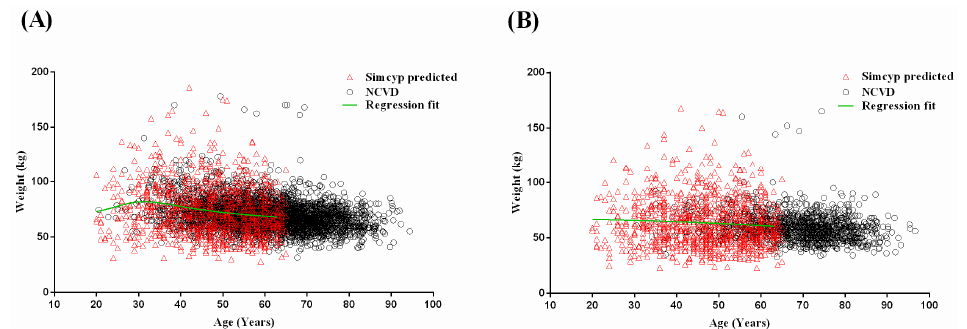
Figure 3. Visual predictive checks on the comparison between predicted and observed (NCVD) age–weight relationship for Chinese male ( n = 7445) ( A ) and female ( n = 2484) ( B ) population. Red outlined triangles represent the Simcyp predicted population age–weight relationships. Black outlined circles represent the observed population age–weight relationships from the NCVD database. Green lines represent the fitted trend-line from the polynomial mathematical relationship.